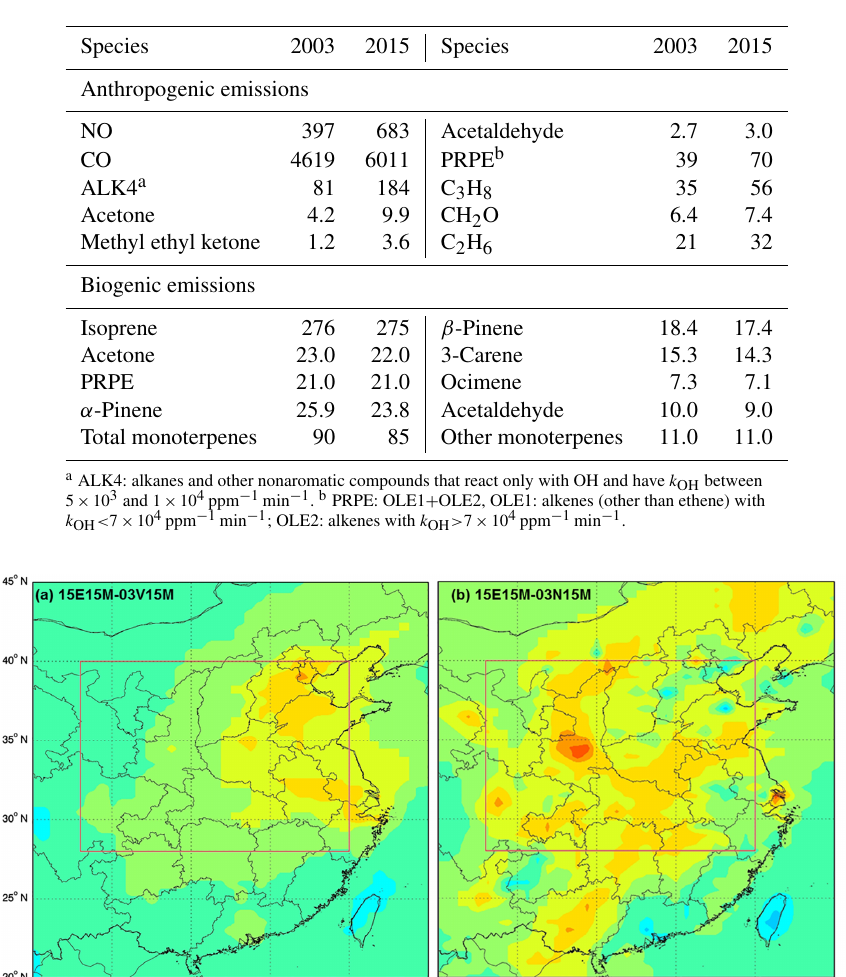
Table 3. Emissions of NO x , CO and NMVOCs over CEC for July 2003 and July 2015, including anthropogenic emissions and biogenic emissions. Units: NO, CO and CH 2 O: Ggmonth − 1 ; others: GgCmonth − 1 .